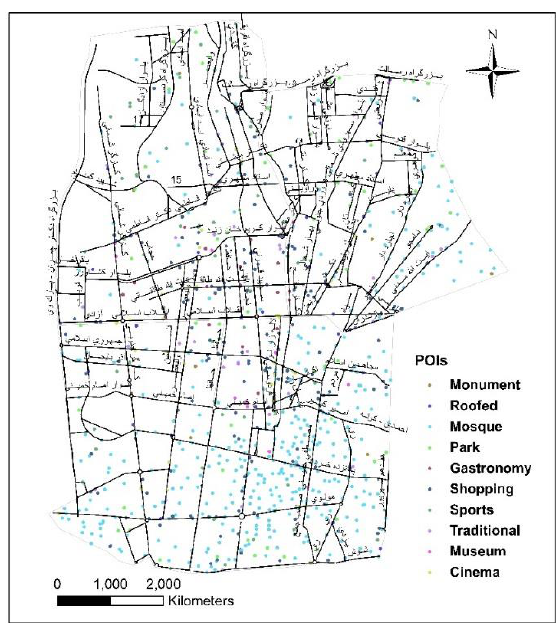
Figure 4. The dataset for the case study